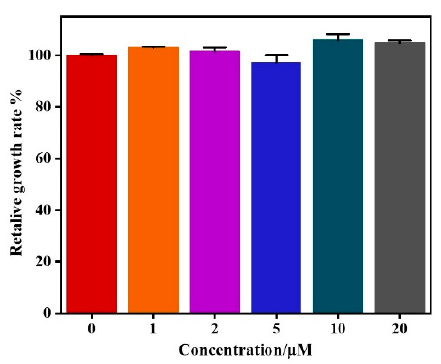
Figure 4. Relative growth rate (%) of cells that were cultured in the presence of a 0 to 20 μ M probe CMB for 24 h and estimated by the CCK8 assay.